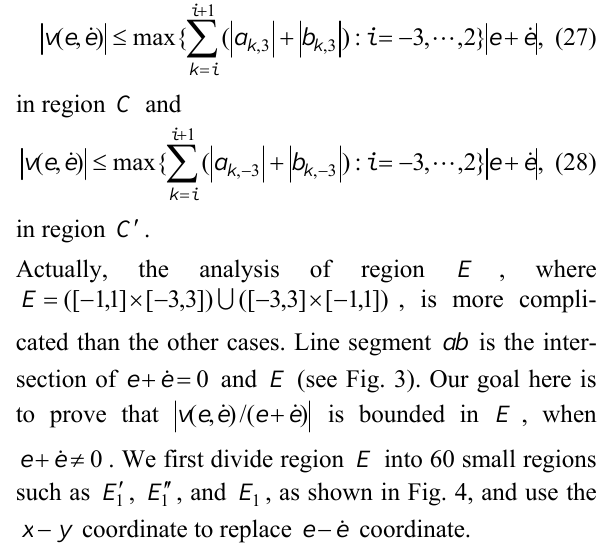
Fig. 4. Partition of region E